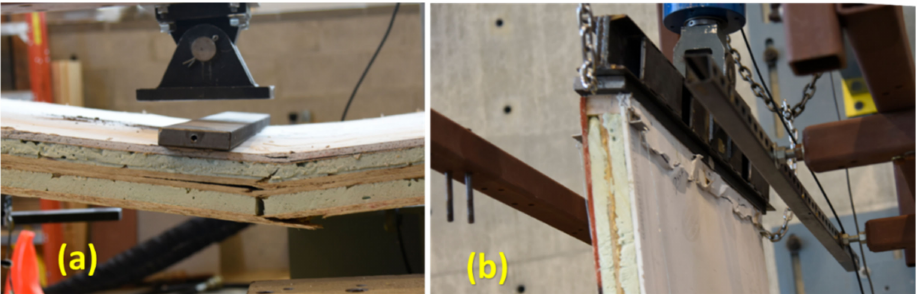
Figure 11. Typical failure of two-layered core sandwich panel under ( a ) bending: tension and ( b ) compression: crushing. Bending and compression results of the sandwich panels were compared with those of structural insulated panels (SIP) and traditional stud walls from the literature, in Table 2.